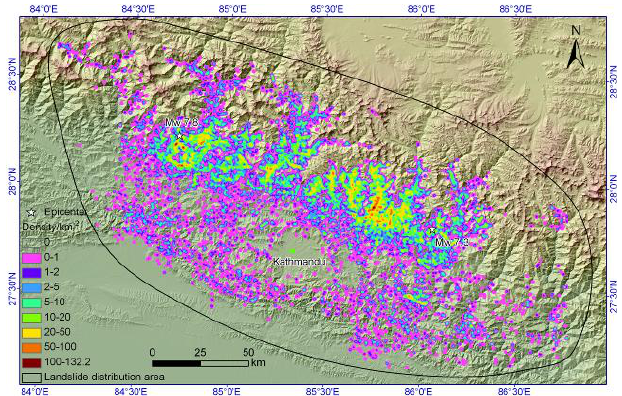
Figure 9. Map showing density of landslides triggered by the 2015 Gorkha